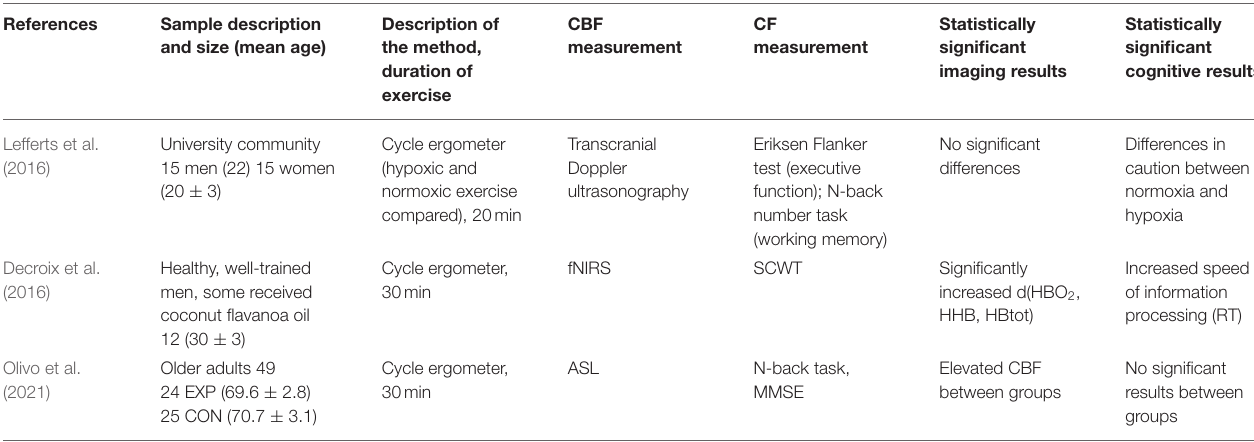
TABLE 3 | Summary of the acute exercise